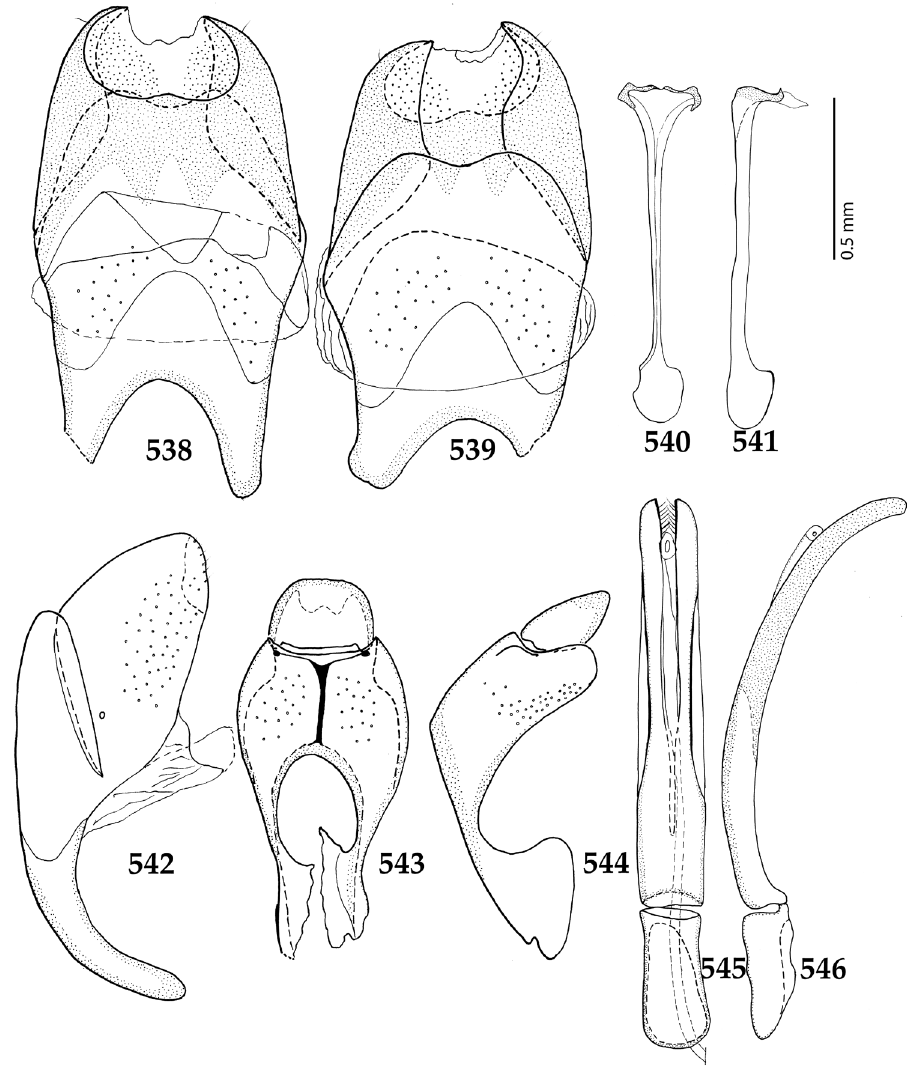
Figures 538–546. 538 Saprinus ( Saprinus ) rarus sp. n. male terminalia: 8 th sternite + 8 th tergite, ventral view 539 ditto, dorsal view 540 male terminalia: spiculum gastrale, ventral view 541 ditto, lateral view 542 male terminalia: 8 th sternite + 8 th tergite, lateral view 543 male terminalia: 9 th + 10 th tergite, dorsal view 544 ditto, lateral view 545 male terminalia: aedeagus, dorsal view 546 ditto, lateral Intercoxal disc of first abdominal ventrite completely striate laterally; surface of disc with scattered punctation, punctures becoming sparser and finer medially. Protibia (Fig. 536) dilated, outer margin with three short triangular teeth topped by short denticle, followed by another short denticle; setae of outer row very short, sparsely paced; setae of median row inconspicuous; protarsal groove very shallow, al-